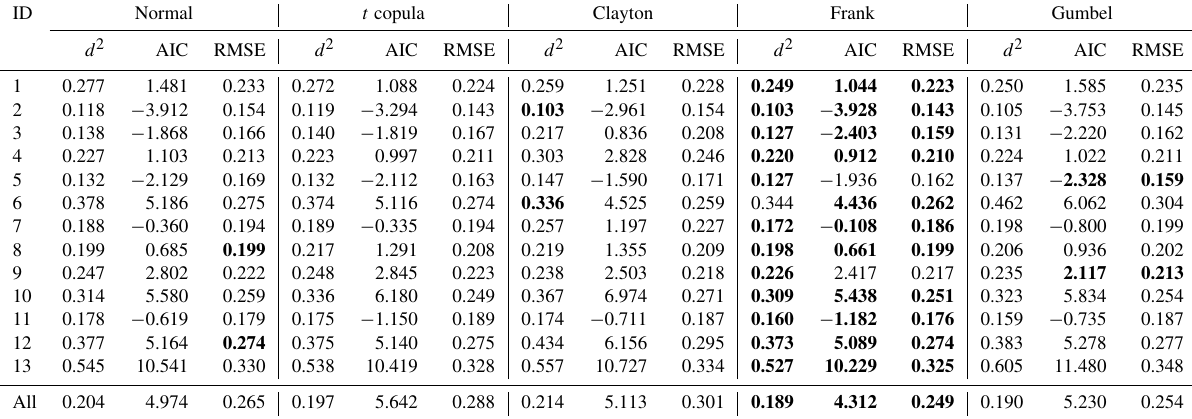
Table 4. The goodness-of-fit values of the copula functions. The optimal of copula function in each watershed is marked with bold font. ID Normal t